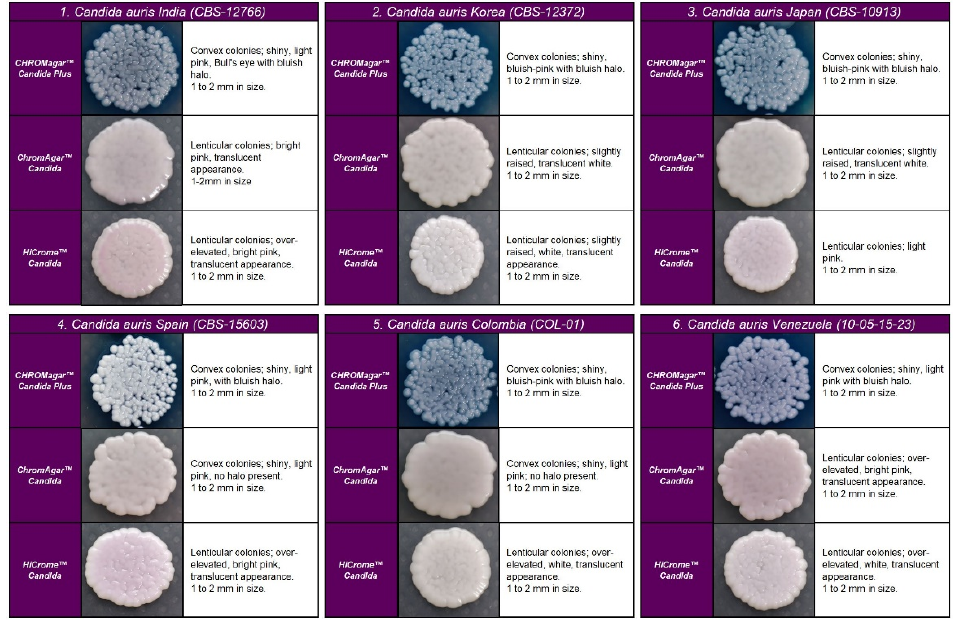
Figure 1. Appearance of Candida auris colonies of the four clades described on CHROMagar™ Candida Plus medium, CHROMagar™ Candida medium, and HiCrome TM Candida after 48 h incubation at 35 °C.